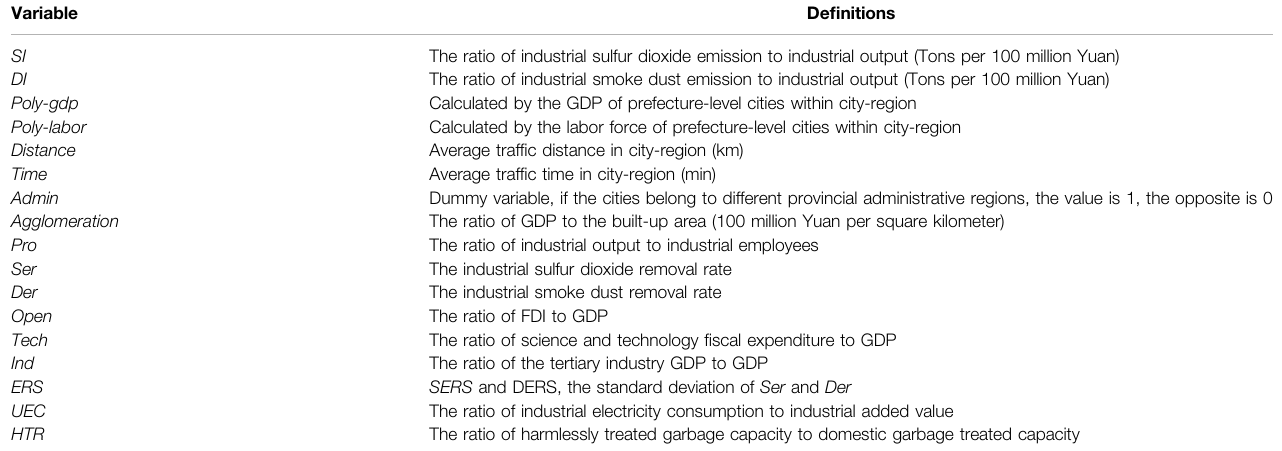
TABLE 1 | De fi nition of variables. Variable